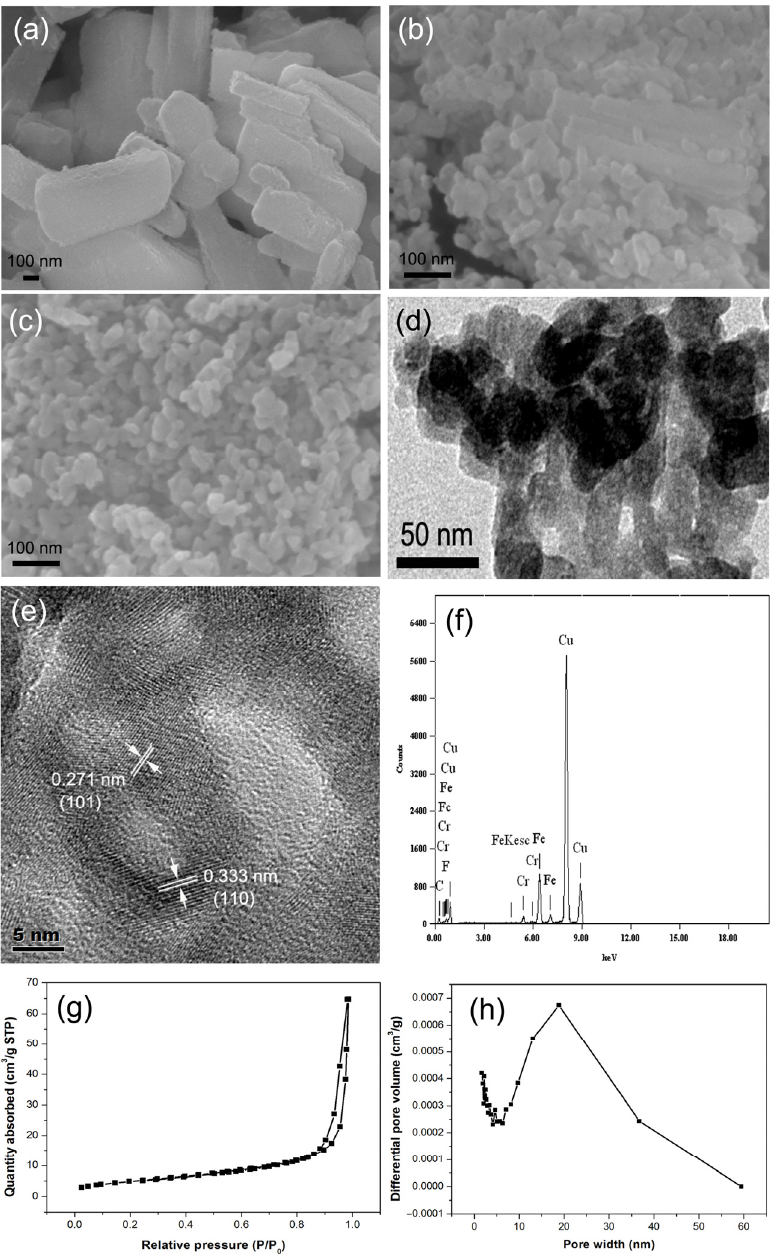
Figure 2. SEM images of the FeF 3 · 3H 2 O precursor ( a ) and the intermediate product FeF 3 · 0.33H 2 O ( b ); SEM image ( c ), TEM image ( d ), HRTEM image ( e ), EDS spectrum ( f ), N 2 sorption–desorption isotherm ( g ) and the pore size distribution ( h ) of FeF 2 nanomaterial.